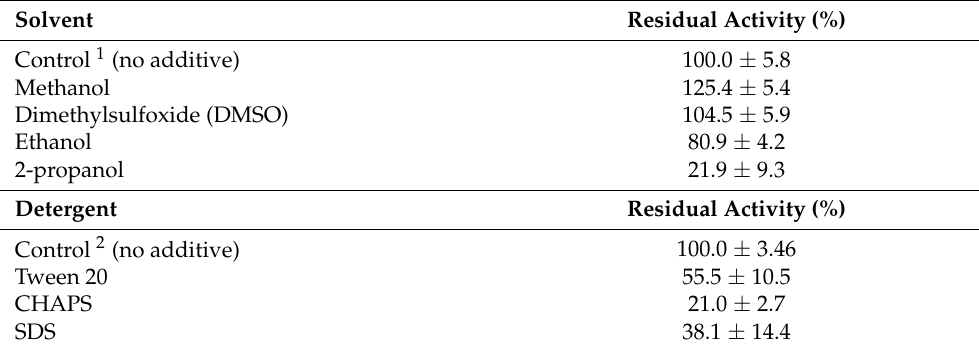
Table 1. Effect of different solvents and detergents on KLEST-3S